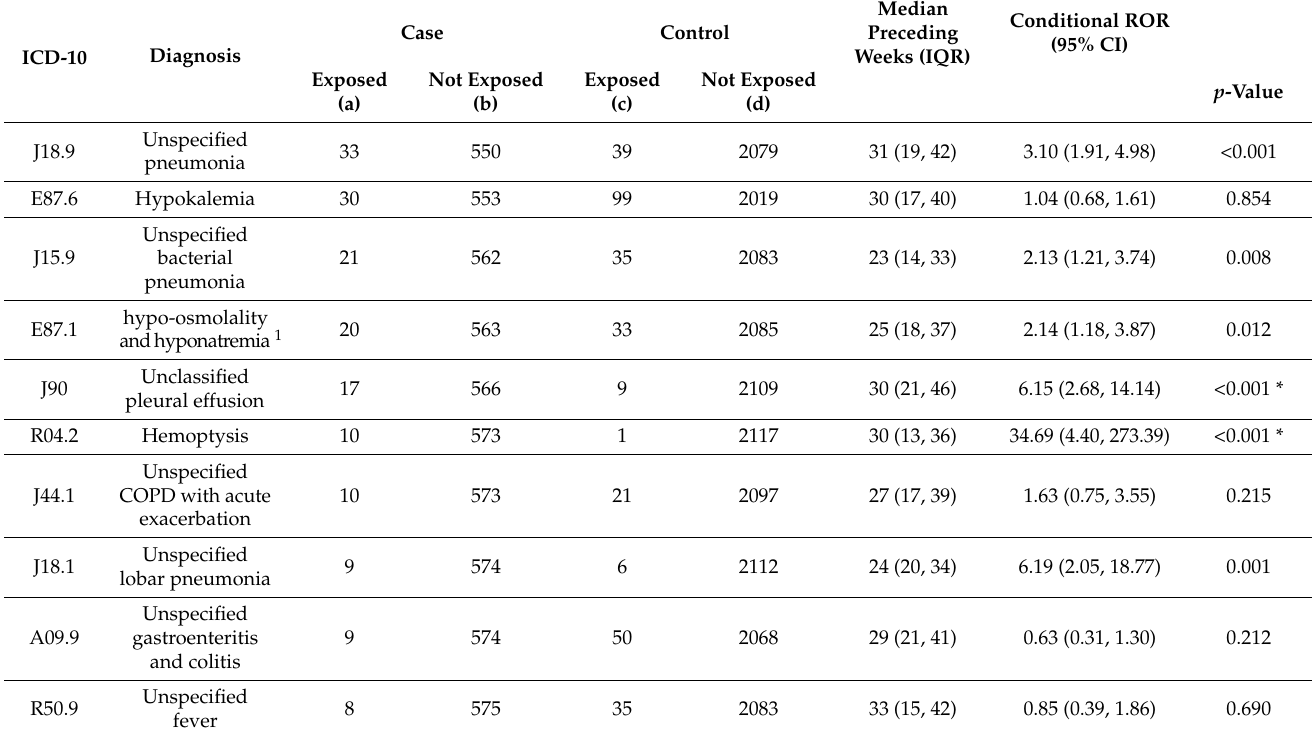
Table 3. Ten most frequent hospitalized comorbidities preceding